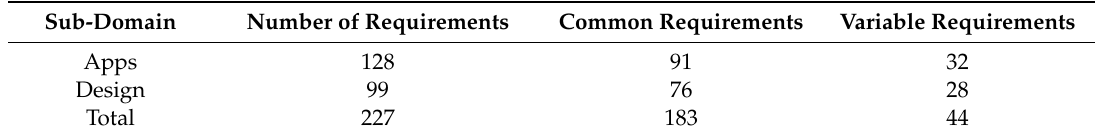
Table 6. Common and Variable Requirements Collected by